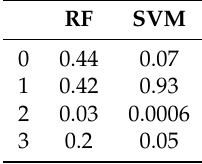
Table 2. Table of optimal cut-off values for each class for RF and